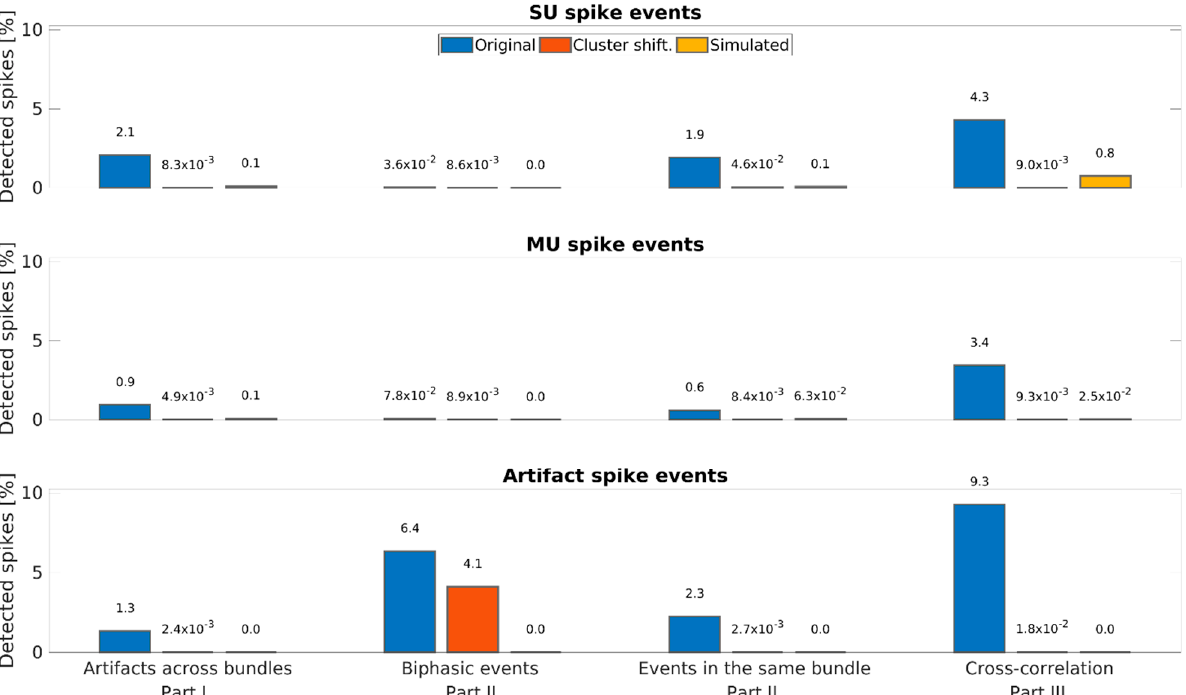
Figure 5. Estimation of the false-positive rate of the DER algorithm. Performance of the DER algorithm for three different datasets: original recorded data are shown in blue, cluster-wise time-shifted surrogate data are shown in red, and simulated data based on [58] are shown in yellow. The top panel shows the percentage of SU spike events found by the different parts of the DER algorithm. The middle and bottom panels show the same analyses for multi-unit and artifact clusters, respectively. The cluster shifted data as well as the simulated data are used to estimate the false-positive rate and thus specificity of the DER algorithm.